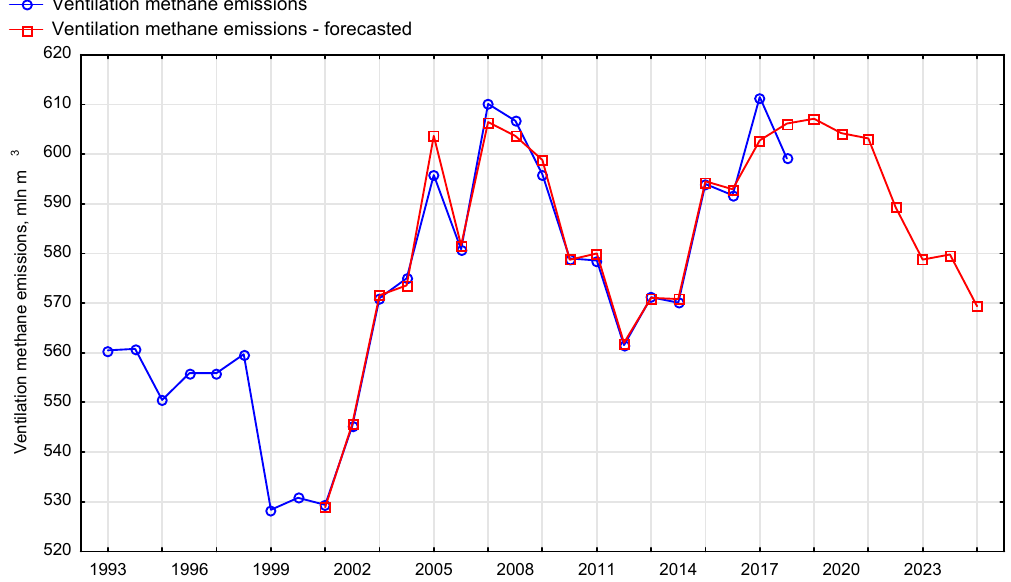
Figure 13. Actual and predicted amount of ventilation methane emissions into the atmosphere.